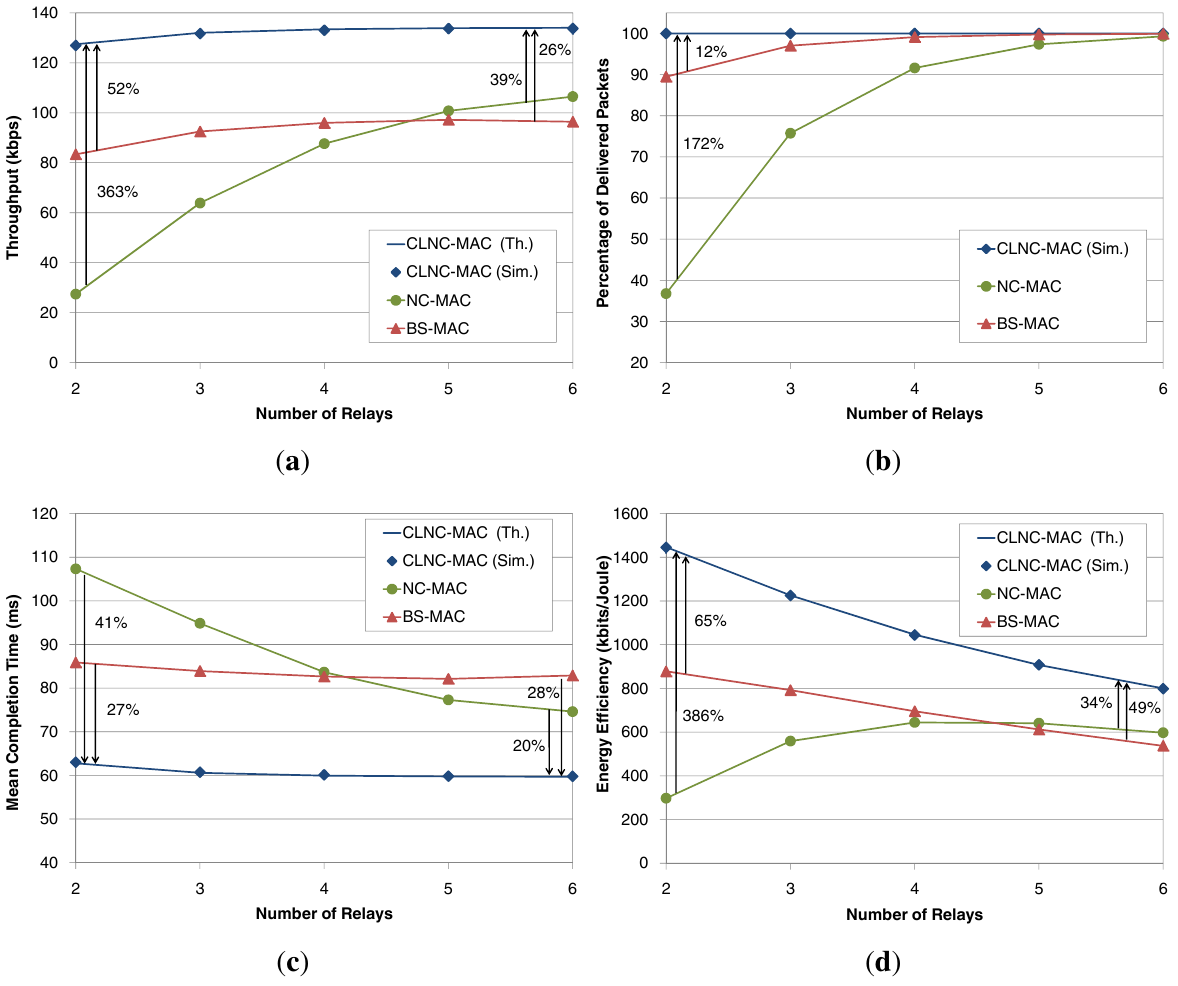
by Th. and Sim., respectively) as a function of the number of relays, for p ( a ) Throughput; ( b ) percentage of successfully delivered packets; ( c ) mean data delay; ( d ) energy